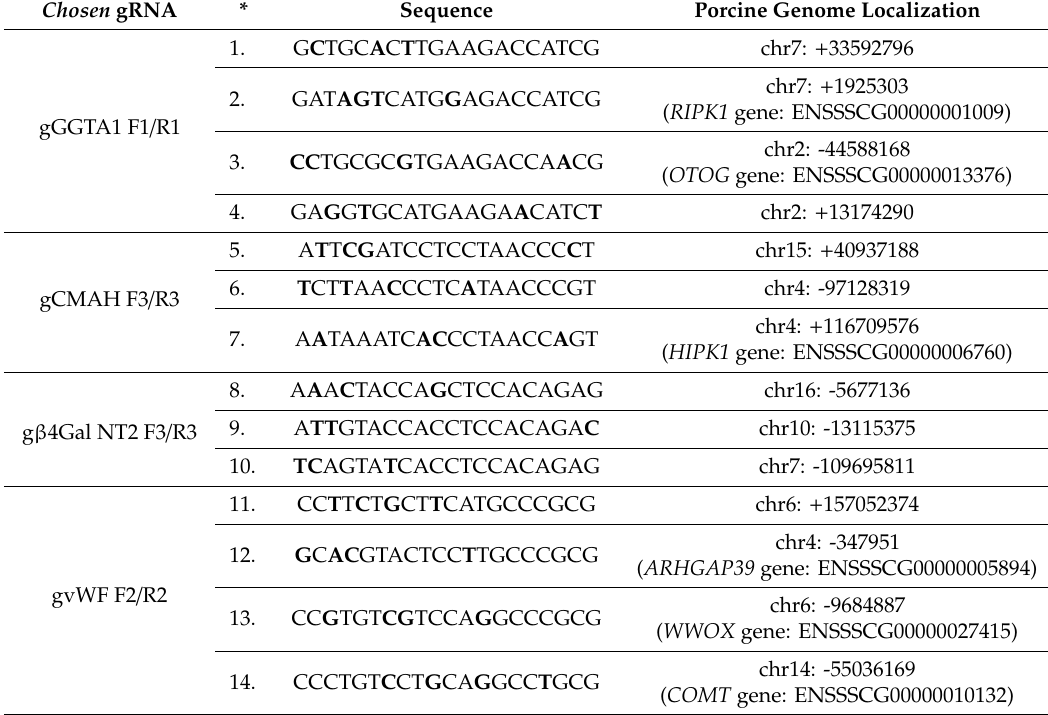
Table 3. A summary of bioinformatically predicted potential o ff -target sites for selected genetic